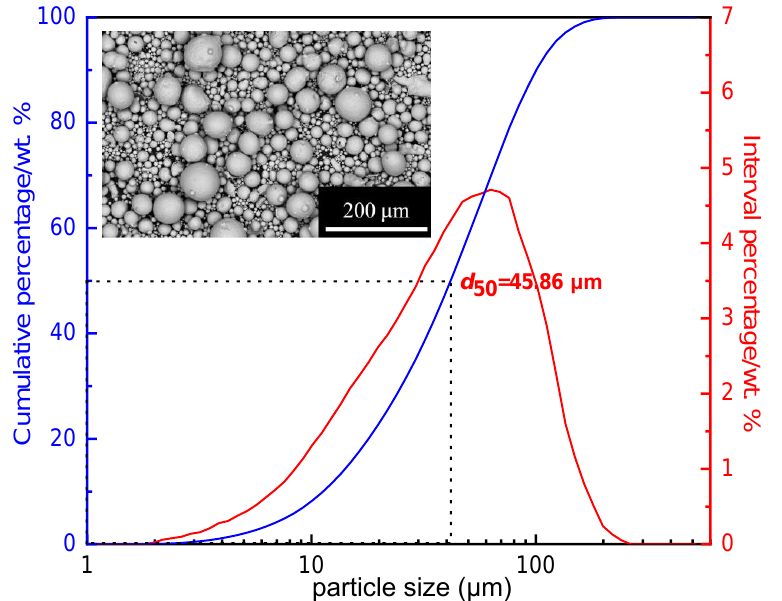
Figure 3. Size distribution of FeSiAl raw powders; the inset is the SEM image of FeSiAl powders. The SEM images shown in Figure 4 P0–P6 show the evolution of the surface morphol- ogy of FeSiAl powders under different EP contents. It can be seen that with the increase of EP content, the surface of the powders is gradually dim, and small particles adhere to the surfaces of large particles. Among them, obvious EP agglomerations on the surface of P5 and P6 can be observed, while there is less for P4. This indicates that when the EP content exceeds 1 wt. %, the powder surface is unevenly coated, resulting in agglomerations of EP. It is worth mentioning that by controlling the amount of EP added, small particles